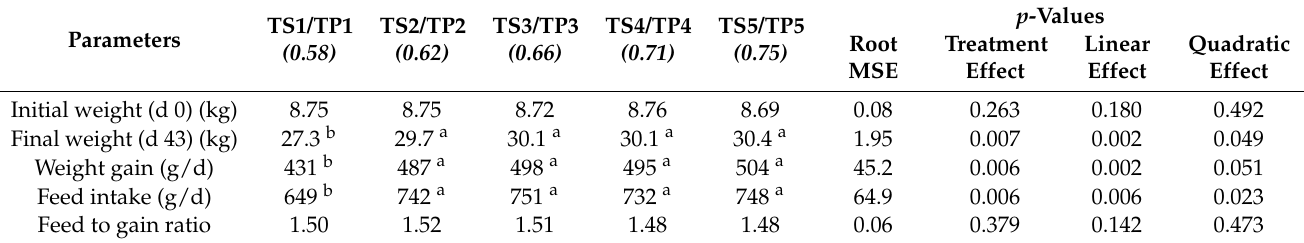
Table 7. Performance parameters of piglets between day 0–43 of trial (whole